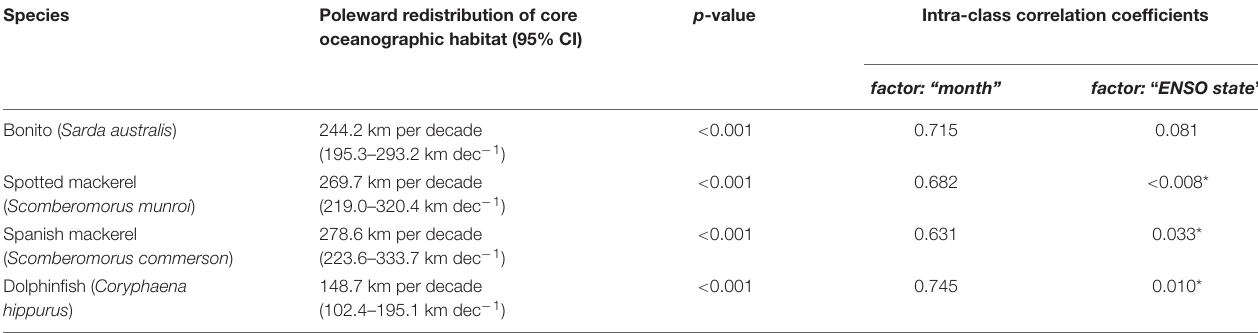
TABLE 2 | Summary of range shift analyses. Species Poleward redistribution of core